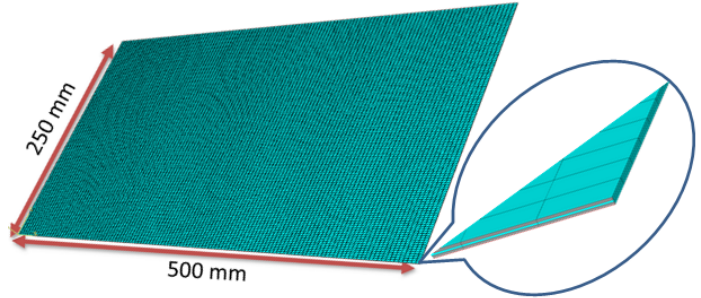
Figure 1. Dimensions of the blank composite sheet.